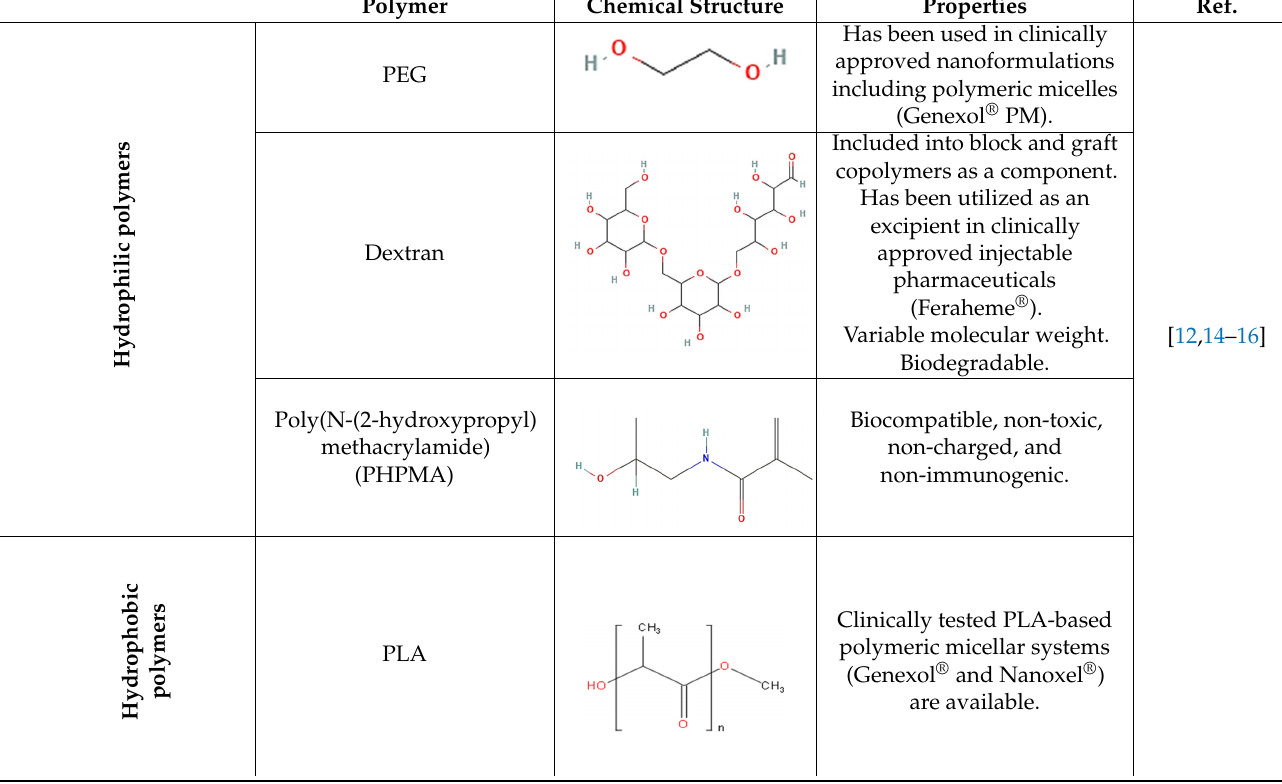
Table 1. Examples of hydrophobic and hydrophilic polymers with their corresponding properties, as well as amphiphilic block copolymers frequently utilized in the creation of polymeric micelles.